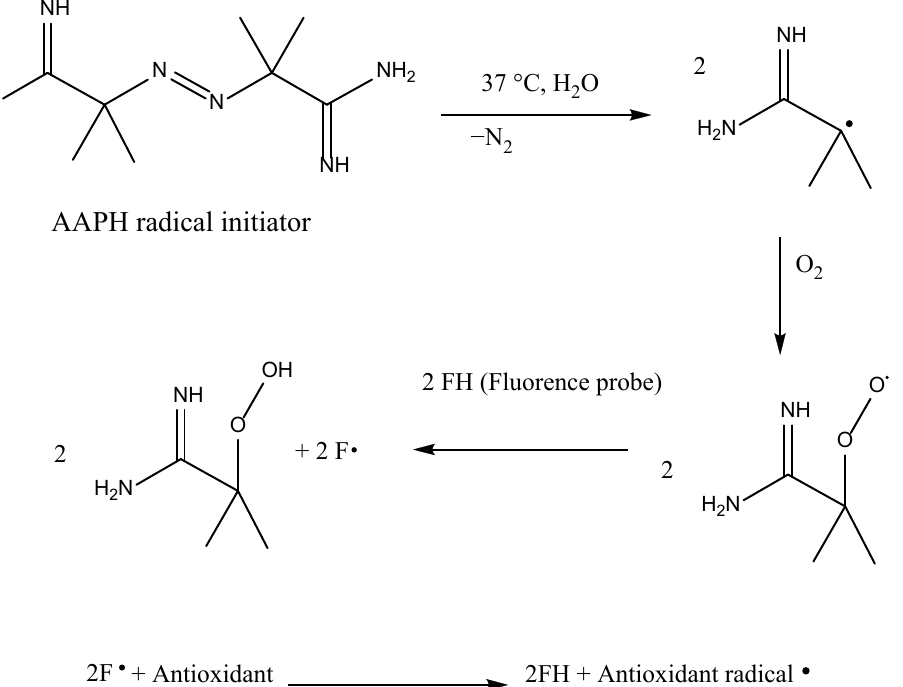
Figure 14. AAPH generates free radicals and afterwards, the reaction between the fluorescence probe and antioxidant occurs [23,112].